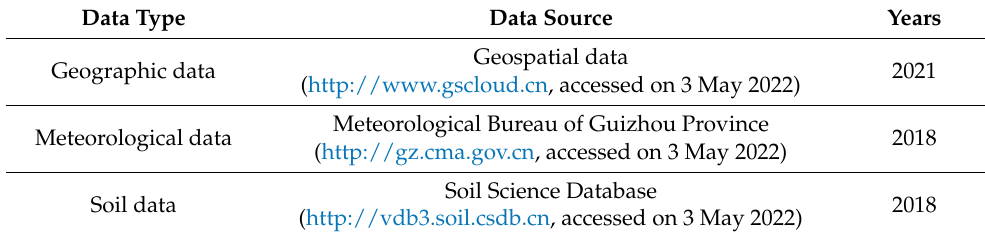
Table 1. Data sources.